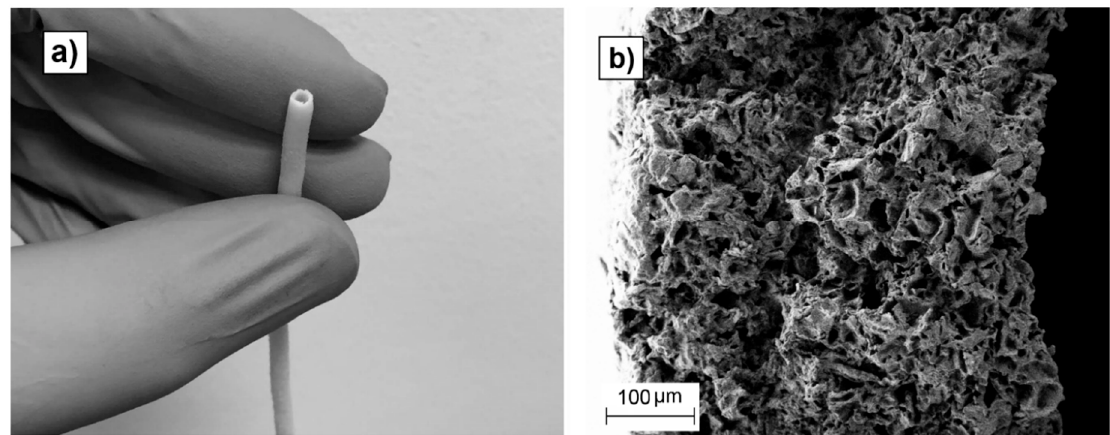
Figure 8. Tube with an inner diameter of 1.5-mm, a wall thickness of 400-µm, and a length of 300-mm produced by micro-extrusion ( a ); SEM image of a section of the tube wall (<500-µm) showing its porous structure ( b ).